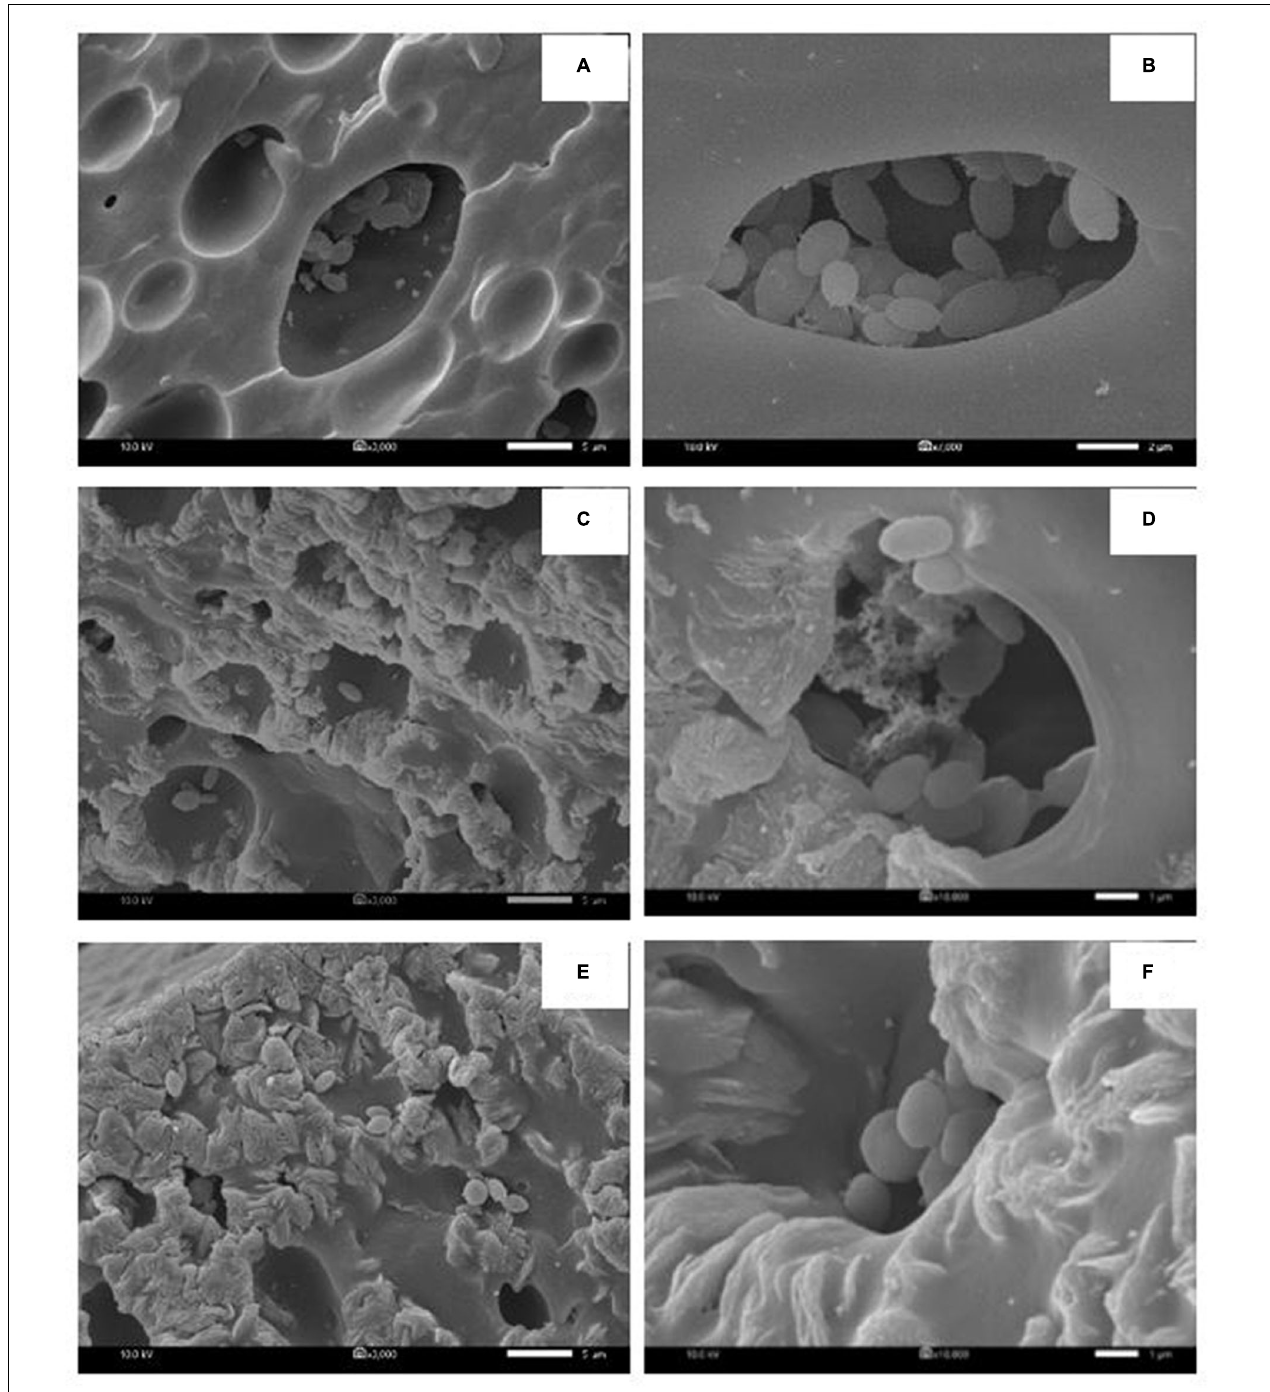
FIGURE 2 | Characteristic of immobilized cells before biosurfactant production (A,B) , after the 1st production cycle (C,D) and after the 3rd production cycle (E,F) . The 3000X magnified image is shown on the left while the 10000X magnified image is displayed on the right. The immobilized cells from the 1st and 2nd biosurfactant production cycles were reused without washing process.